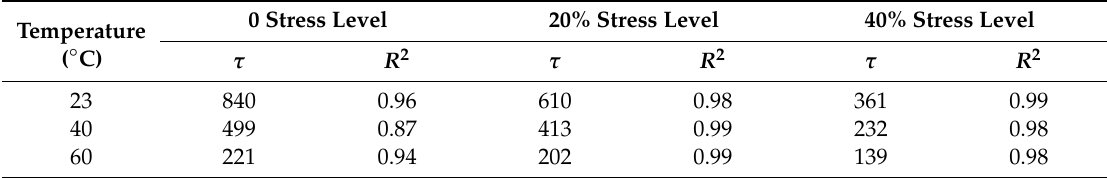
Figure 12. Fitted curves for tensile strength retention versus time: ( a ) 0% stress level; ( b ) 20% stress; Table 6. Coe ffi cients of regression in Equation (2). ( c ) 40% stress level. Table 6. Coefficients of regression in Equation (2).